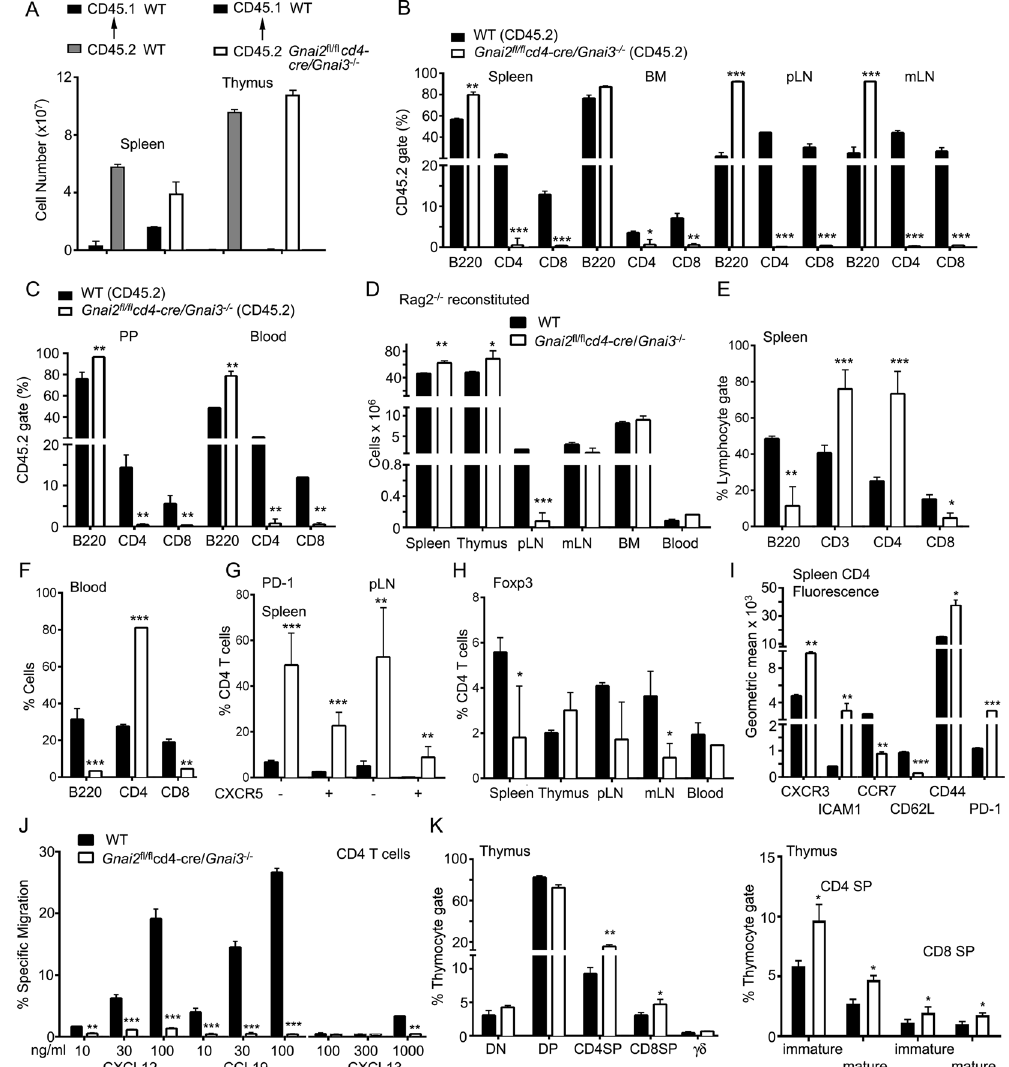
Figure 5. Reconstitution of WT and Rag2 − / − mice with DKO bone marrow results in different phenotypes. ( A ) Number of splenocytes and thymocytes recovered from WT reconstituted mice. CD45.1 WT mice were lethally irradiated and reconstituted with bone marrow from CD45.2 WT or CD45.2 DKO mice. Seven weeks later the number of CD45.1 and CD45.2 cells in the spleen and thymus were enumerated. ( B , C ) The percentage of different cell types in the lymphocyte gate that also expressed CD45.2. Cells were isolated from the spleen, bone marrow (BM), pLN, and mLN ( B ) and PP and blood ( C ) from the reconstituted mice. ( D ) Number of lymphoid cells recovered from Rag2 − / − reconstituted mice. CD45.1 Rag2 − / − mice were lethally irradiated and reconstituted with bone marrow from CD45.2 WT or CD45.2 DKO mice. Seven weeks later the number of CD45.1 and CD45.2 cells in various lymphoid organs were enumerated. ( E,F ) Lymphocyte subsets in the spleen ( E ) and blood ( F ) of Rag2 − / − reconstituted mice. ( G ) Distribution of PD-1 + CXCR5 positive or negative CD4 T cells in the spleen and pLNs of Rag2 − / − reconstituted mice. ( H ) Percentage of Foxp3 + CD4 T cells in different lymphoid organs and the blood. ( I ) Comparison of indicated cell surface markers on CD4 T cells from Rag2 − / − bone marrow reconstituted mice. Data presented as a geometric mean. ( J ) Chemotaxis assays with increasing concentrations of S1P, CXCL12, and CCL19 as indicated. Shown are the percentage of CD4 T cells from Rag2 − / − mice reconstituted with the indicated bone marrow that specifically migrated. ( K ) Distribution of thymocyte subsets in Rag2 − / − mice with bone marrow from WT or DKO mice. Results are from 8 mice WT or 8 Rag2 − / − mice reconstituted either with WT or DKO mice. * p < 0.05, ** p < 0.005 and *** p < 0.0005 (Student’s t